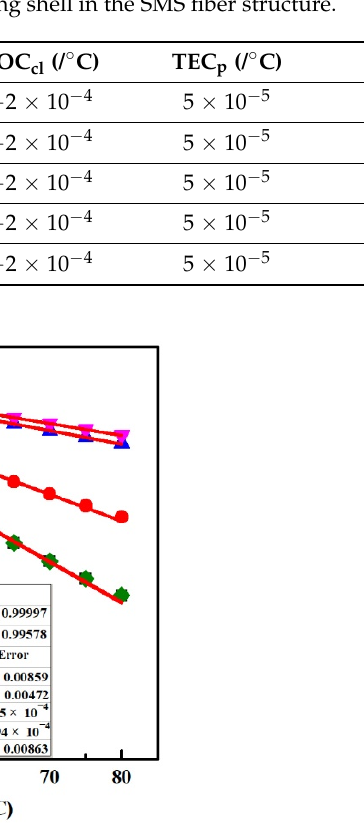
Figure 11. Dip Wavelength as a function of the temperature for SMS fiber structures, various thermal effects are all taken into account in the simulation.